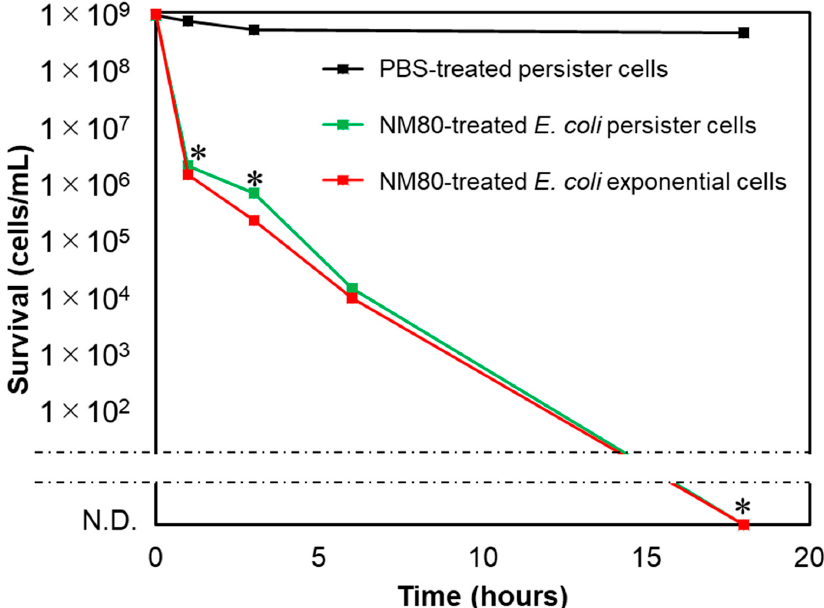
Figure 6. Bactericidal effect of NM80 against E. coli persister cells. The red line is the NM80-treated E. coli exponential cells, and the green line indicates NM80-treated E. coli persister cells. The black line indicates the PBS-treated E. coli persister cells as a control. N.D. means “not detected.” Student’s t -tests were used to compare the bactericidal effects of nanoparticle-treated samples relative to PBS- treated samples (persister) (* indicates a p -value < 0.05).